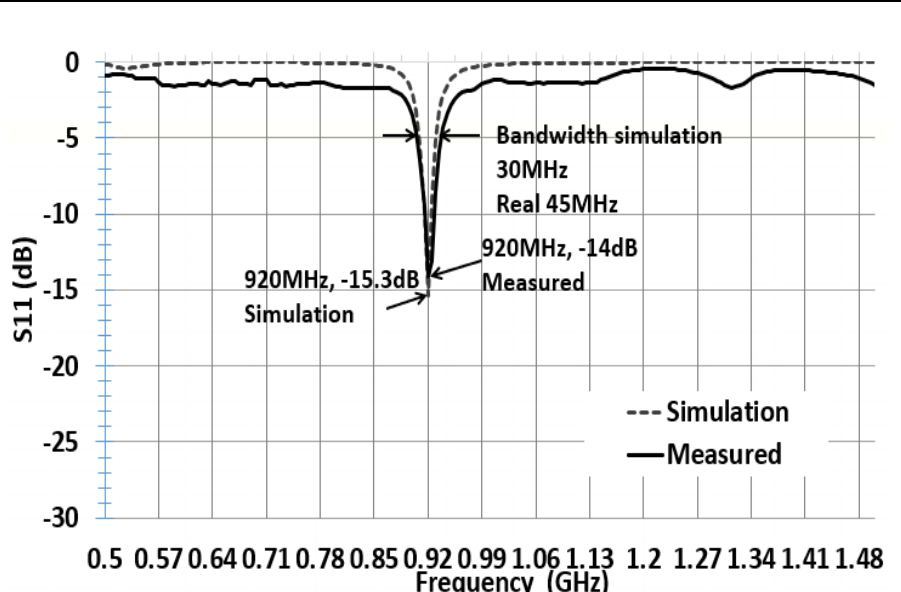
Figure 13. Simulated and measured S11 with parameter ant_h4 in Table 2.